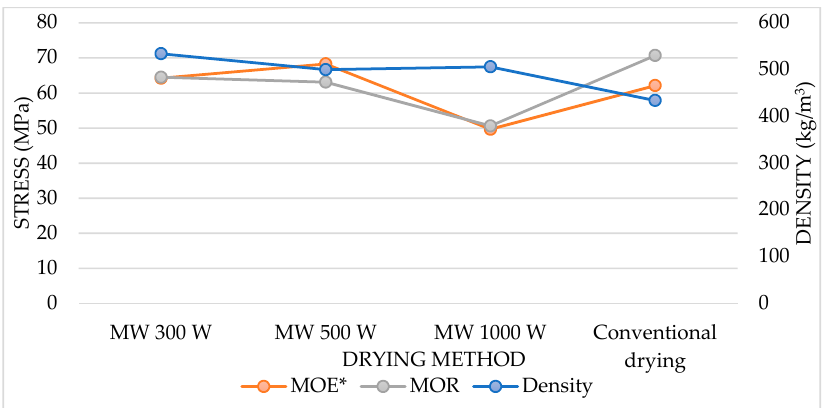
Figure 2. Variations in MOE, MOR, and density found by [2] ; * MOE values are divided by 100. Using MW energy, Aksenov and Malyukov [48] investigated the drying duration of both birch and aspen wood and the effect on the strength and hardness of wood samples. To do this, the authors [48] used specimens with MC between 30% and 60% and created an innovative experimental installation with pulsed action. The results showed that MW drying could diminish the drying time of softwood species fivefold in